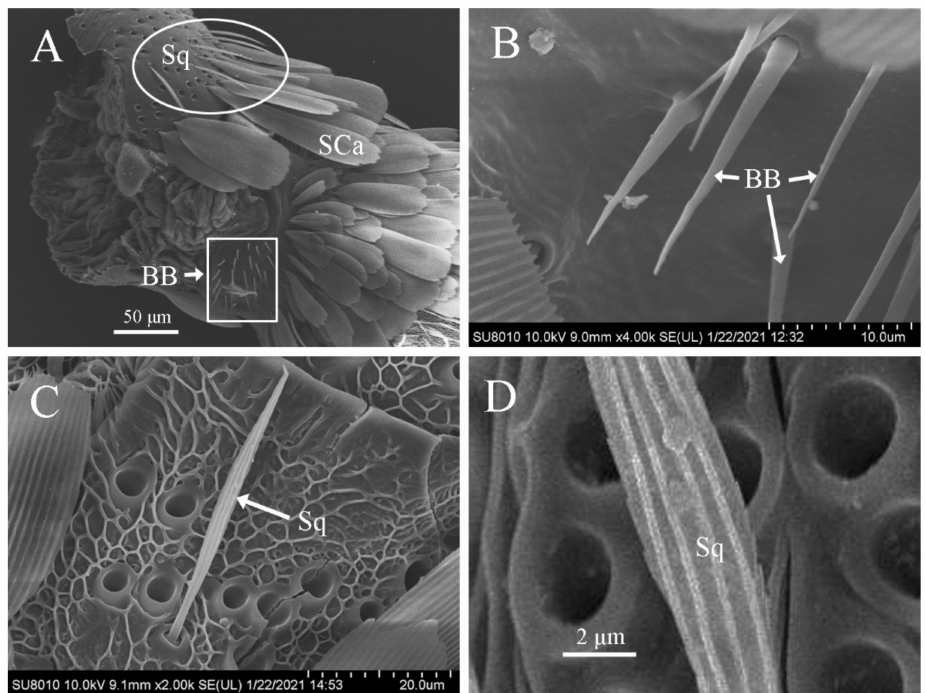
Figure 4. Scanning electron micrographs of Böhm’s bristles and sensilla squamiformia on the antennae of Dioryctria rubella . ( A ) Böhm’s bristles (BB) and sensilla squamiformia (Sq) on the basal antennae; ( B ) Böhm’s bristles; ( C ) sensilla squamiformia; ( D ) close-up of sensilla auricillica. SCa, scales